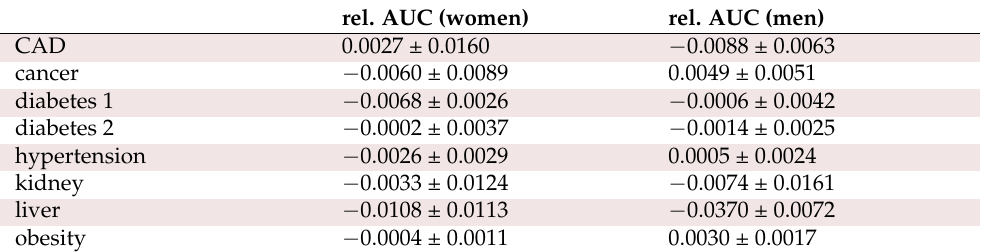
Table 3. Including Principal Component effect on the BMRS predictors has negligible impact on the AUCs. Shown is the relative AUC as computed in Equation (4) for self-reported Europeans within the sibling set, using the mean relative difference for 5 numbered predictors ± the standard deviation.